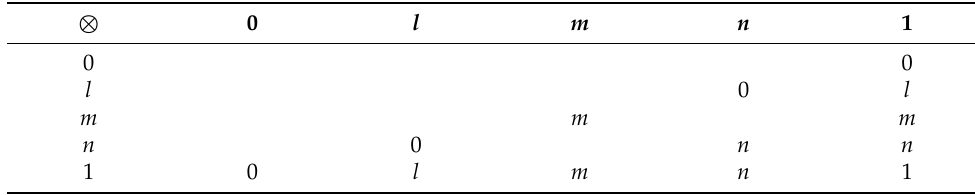
Table 9. The partial operation ⊗